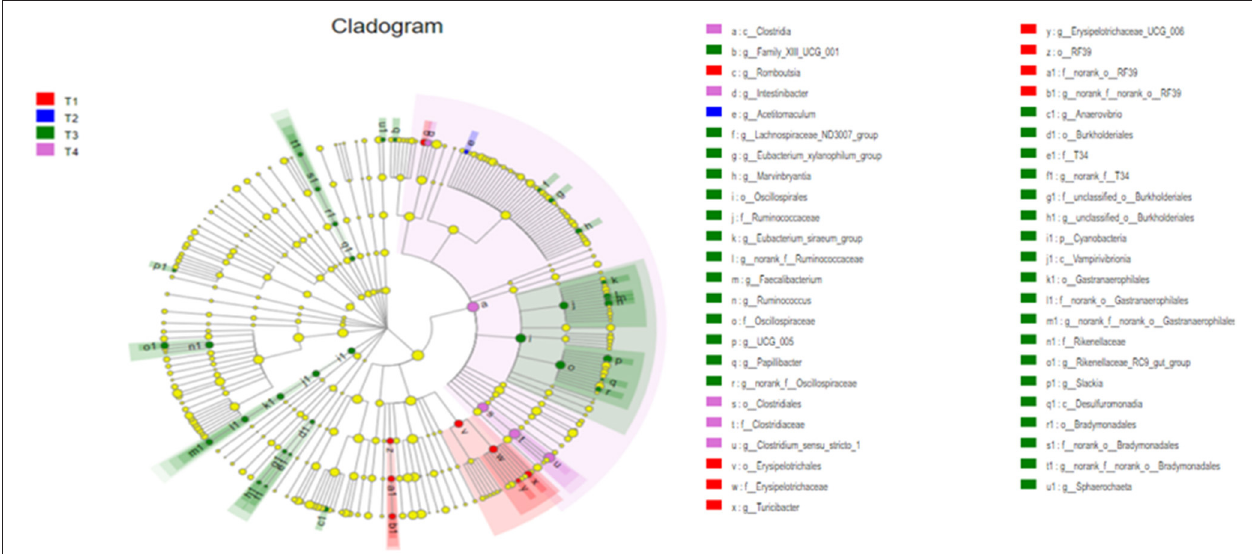
FIGURE 4 | The differently abundant taxa identified using linear discriminant analysis effect size (LEfSe) analysis. The LEfSe cladogram shows the most differentially abundant taxa among the groups. Taxa enriched in the T1 group are red, taxa enriched in the T2 group are blue, taxa enriched in the T3 group are green and taxa enriched in the T4 group are purple. The size of each dot is proportional to its effect